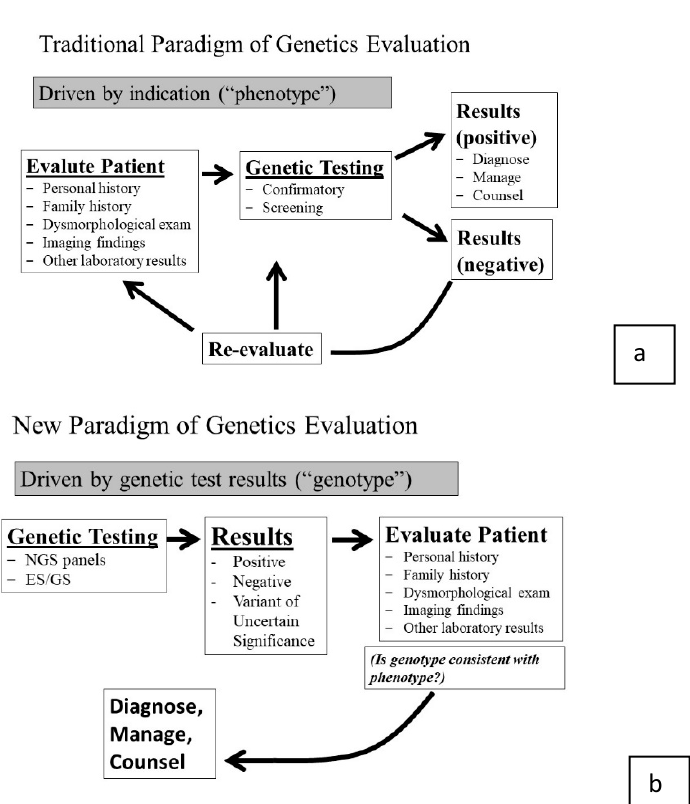
Figure 1. Comparing and contrasting the traditional ( a ) and new ( b ) paradigm of genetic evaluations. Traditionally, evaluation began as a phenotype-first approach. NGS has led to a genotype-first approach where the patient evaluation is more detailed after results have returned, and the geneticist must determine is the genotypic results are consistent with a diagnosis. (Adapted from NH Robin.